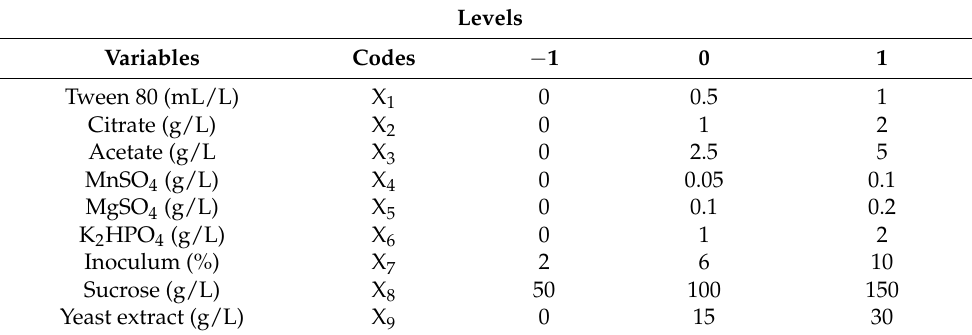
Table 1. Variables and levels used in Plackett–Burman experimental design.